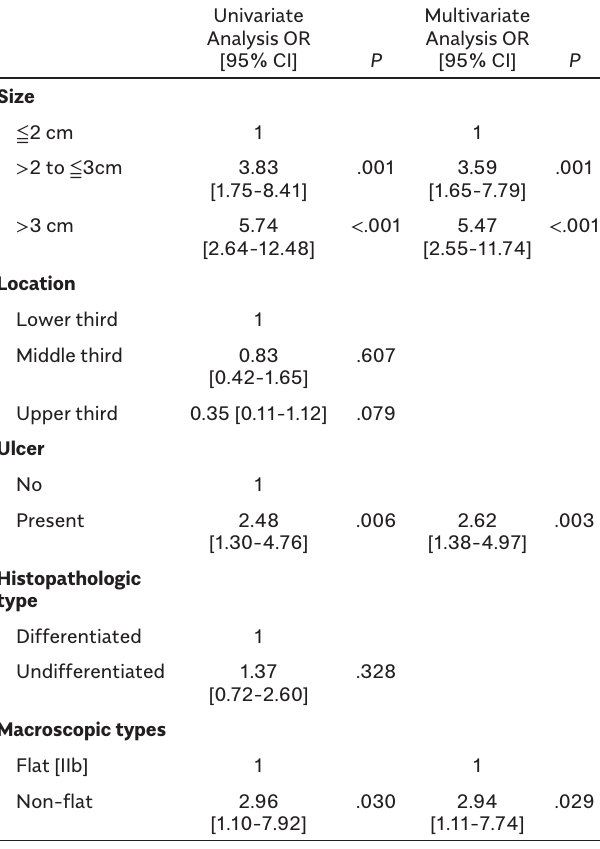
Table 3. Univariate and Multivariate Analysis for Affecting the Table 4. Clinical Factors Affecting the Over- and Underestimation Accuracy of EUS for the Depth of Invasion of EUS for the Depth of Invasion Univariate Overestimation Underestimation Multivariate Analysis OR (n = 59) P (n = 16) Analysis OR [95% CI] P